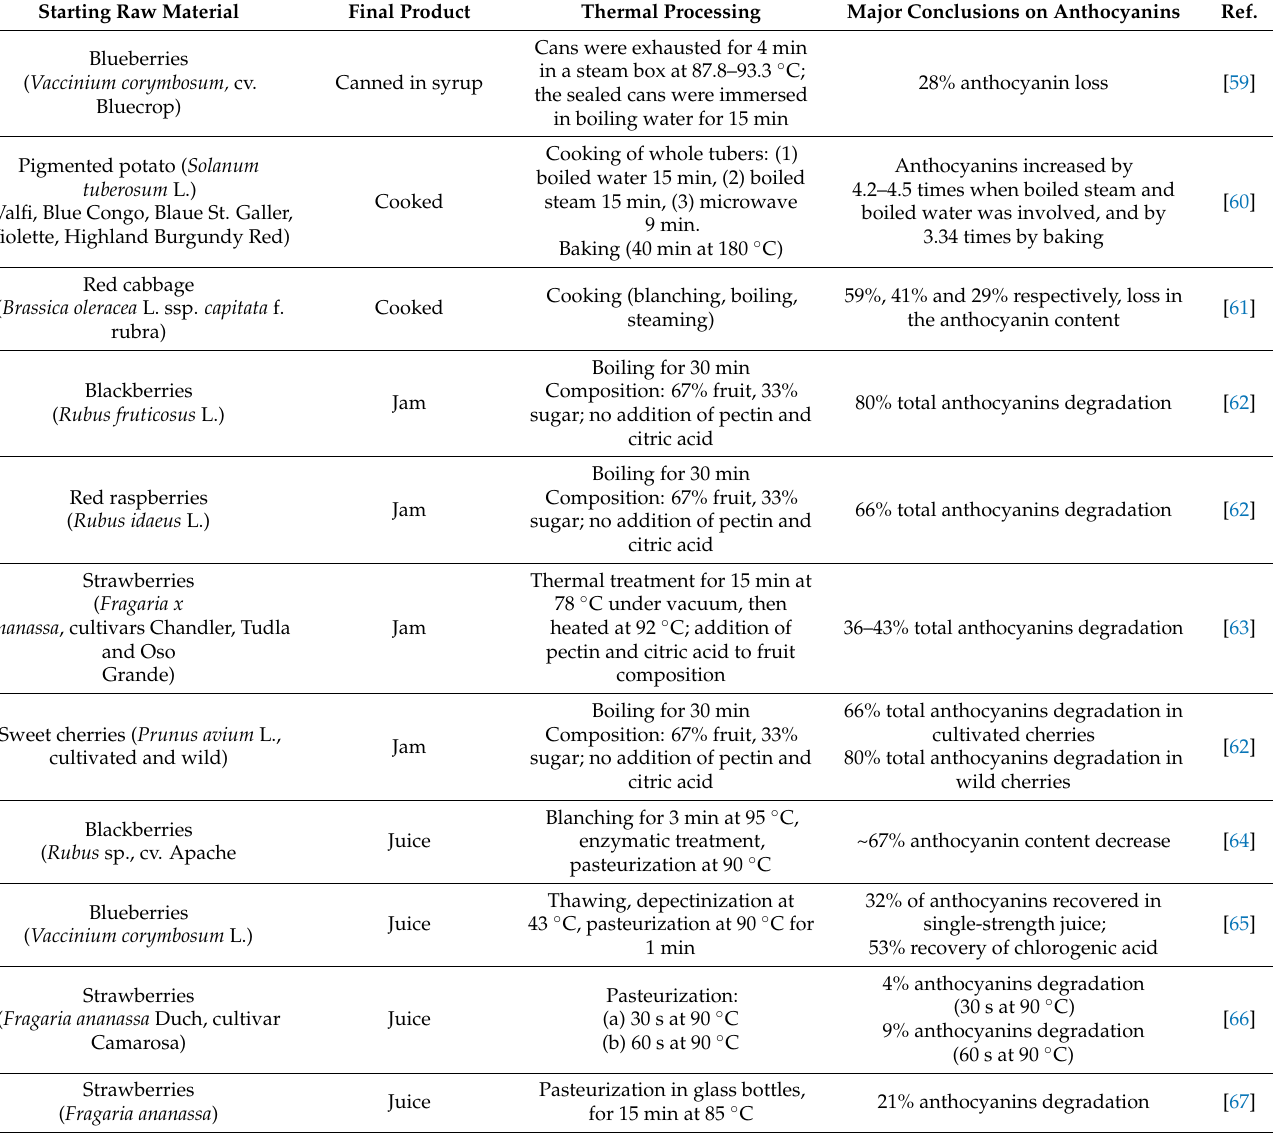
Table 3. The fate of anthocyanins during thermal treatments of food containing these biomolecules. Starting Raw Material Final Product Thermal Processing Major Conclusions on